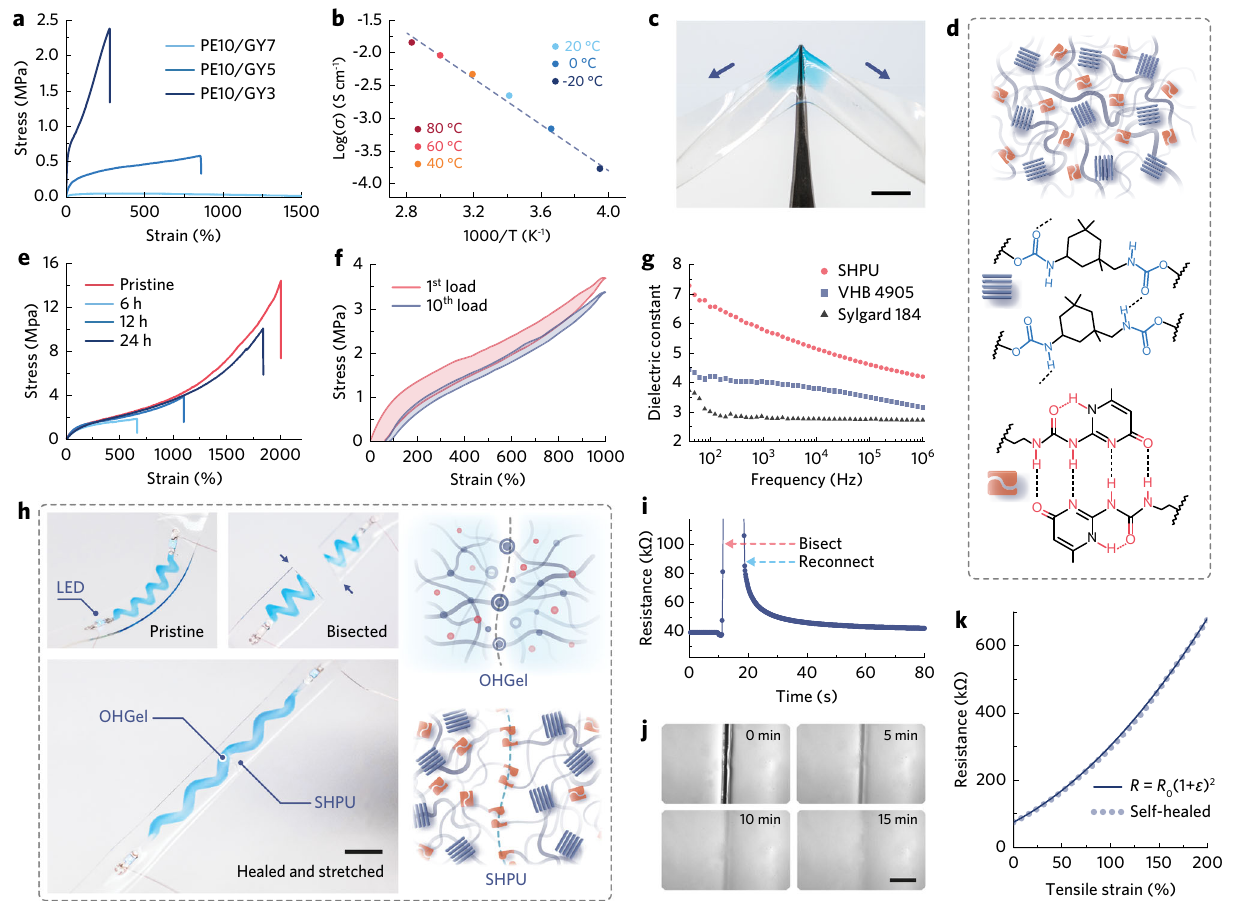
Fig. 2 | Electromechanical properties of OHGel and SHPU. a Uniaxial tensile test results of OHGels with varying PE/GY ratio. Stretching speed, 60mmmin -1 . b Temperature dependence of OHGel ’ s ionic conductivity from − 20°C to 80°C. c Photograph showing a SHPU substrate with OHGel loaded on top resisting the puncturing from a sharp tweezer. Scale bar, 5mm. d Schematic illustration repre- senting the hard-soft phase separation in SHPU (top); molecular structures of urethane hard domain (middle) and UPy-UPy dimer (bottom) that represent the hierarchicalH-bondinginSHPU. e Stress-strainbehaviorsofpristineandself-healed SHPU samples after different healing durations. f Stress-strain cyclic behavior of